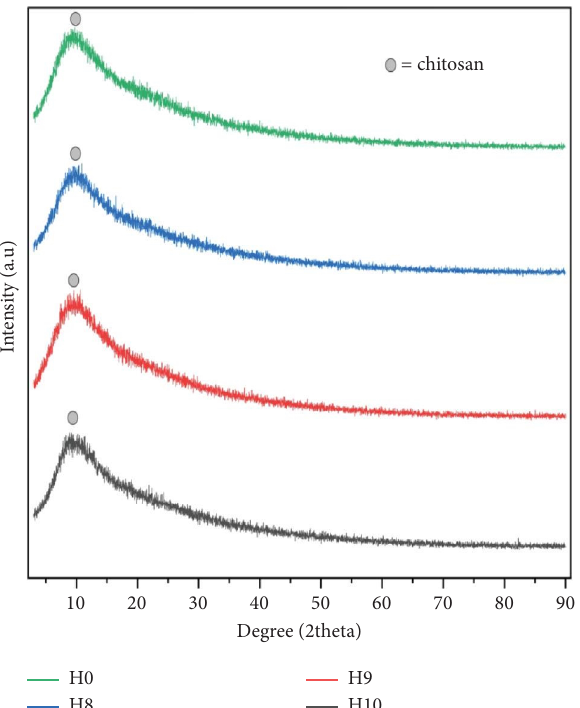
Figure 2: X-ray difractogram for H0 (hydrogel without L. acidophilus ), H8, H9, and H10 (hydrogels with L. acidophilus at numbers of 8 log CFU/mL, 9 log CFU/mL, and 10 log CFU/mL,